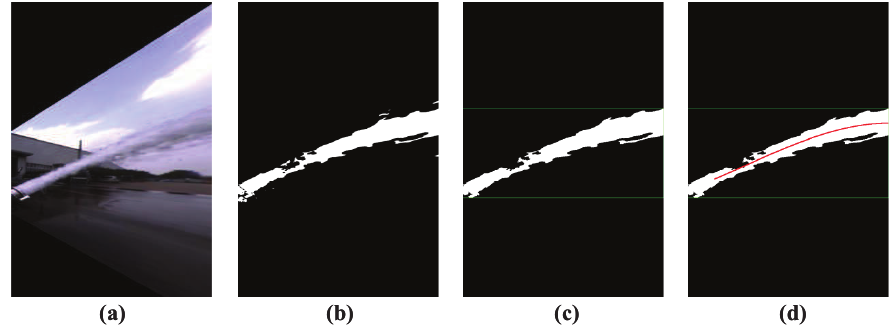
Figure 9. Processed image results after each step of the improved NFCV system. ( a ) preprocessed trajectory; ( b ) background subtraction; ( c ) trajectory discriminant; and, ( d ) trajectory